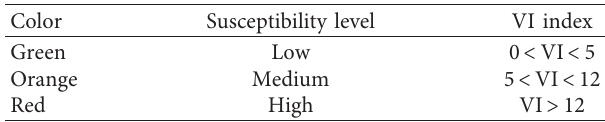
Table 10: Classification of the extent of seismic susceptibility of the wastewater